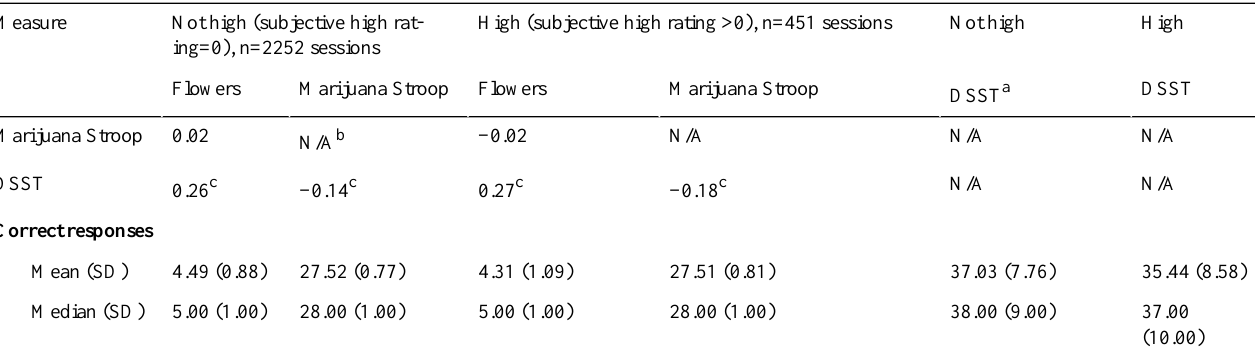
Table 2. Pearson correlations (r) and mean number of correct responses for 3 cognitive tasks (correlations do not take clustering of cases within individuals over time into